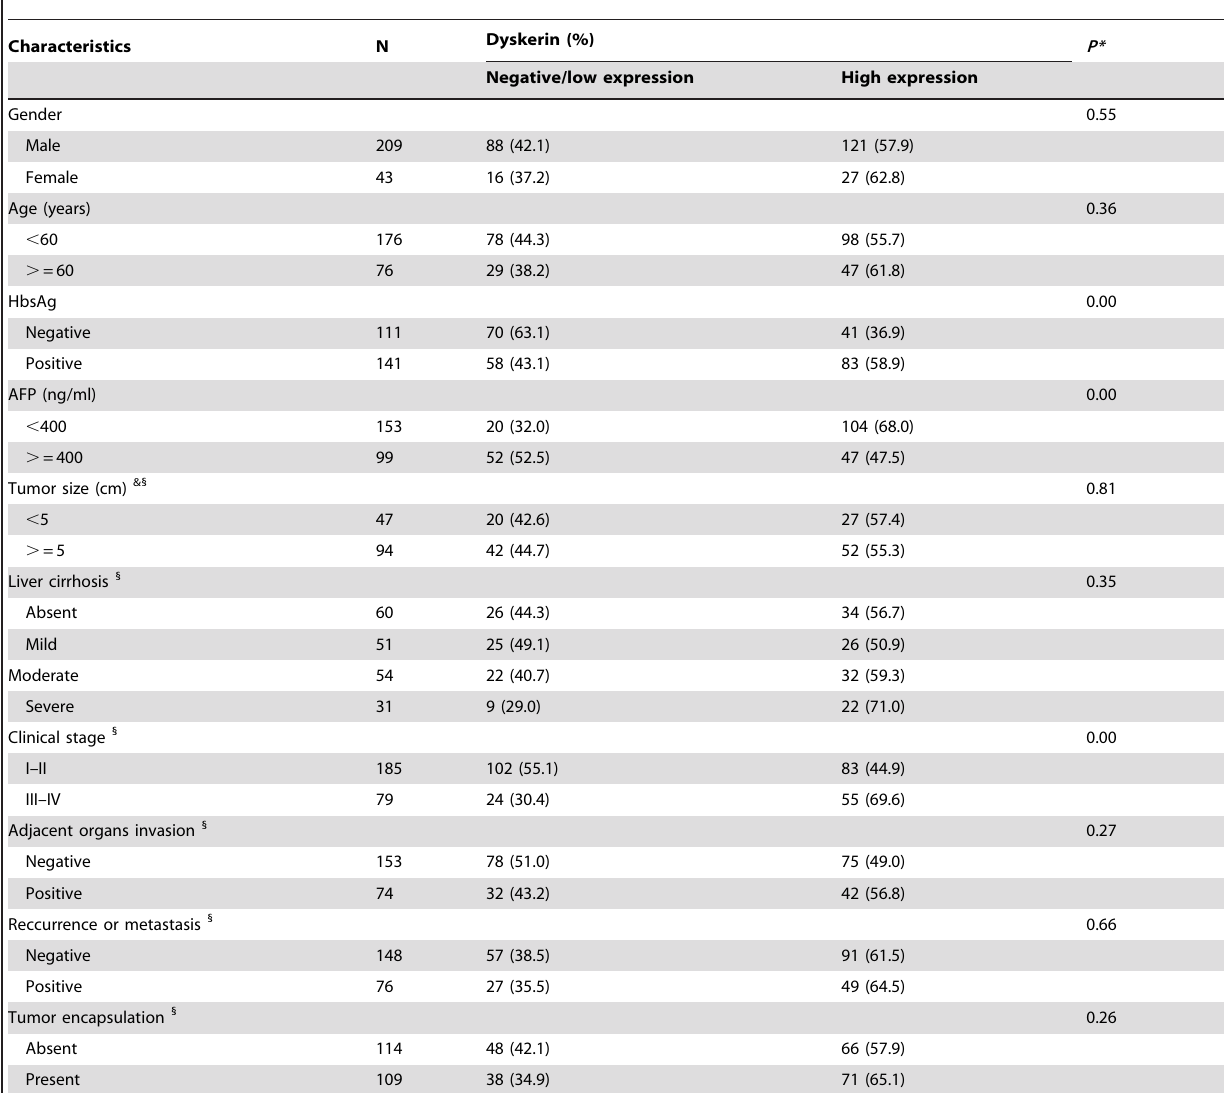
Table 1. Correlations between the clinicopathologic characteristics and dyskerin protein expression in hepatocellular carcinoma.